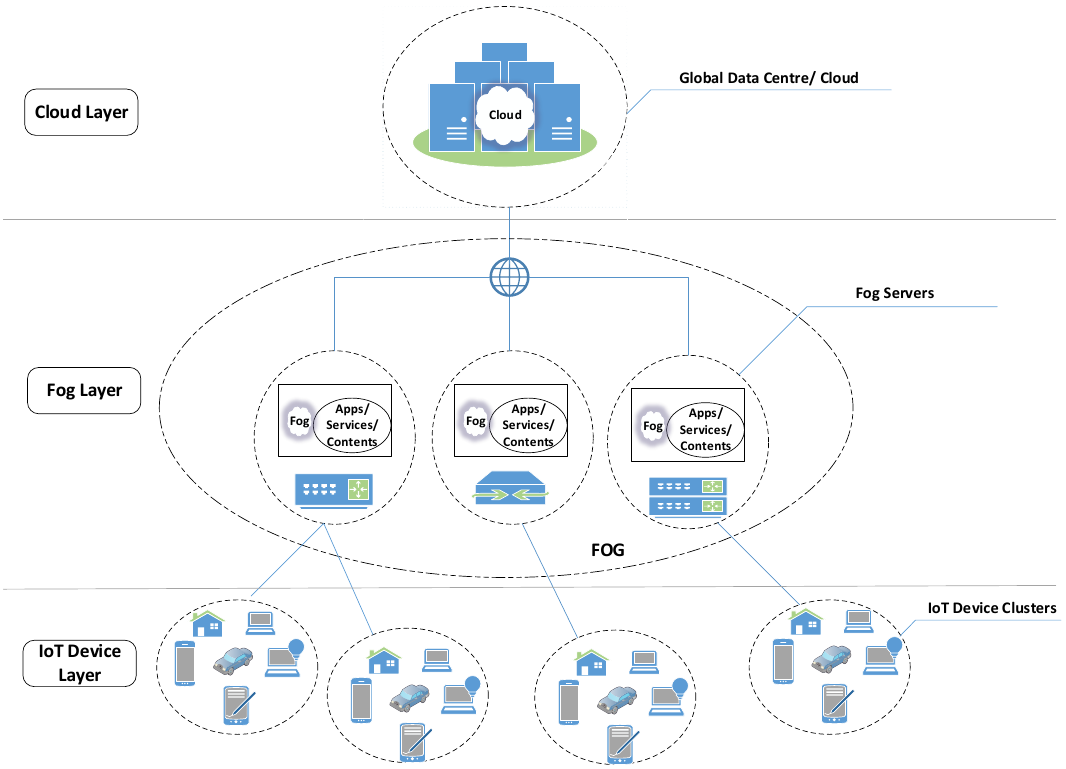
Figure 4. A new generation of the fog-based CAAC